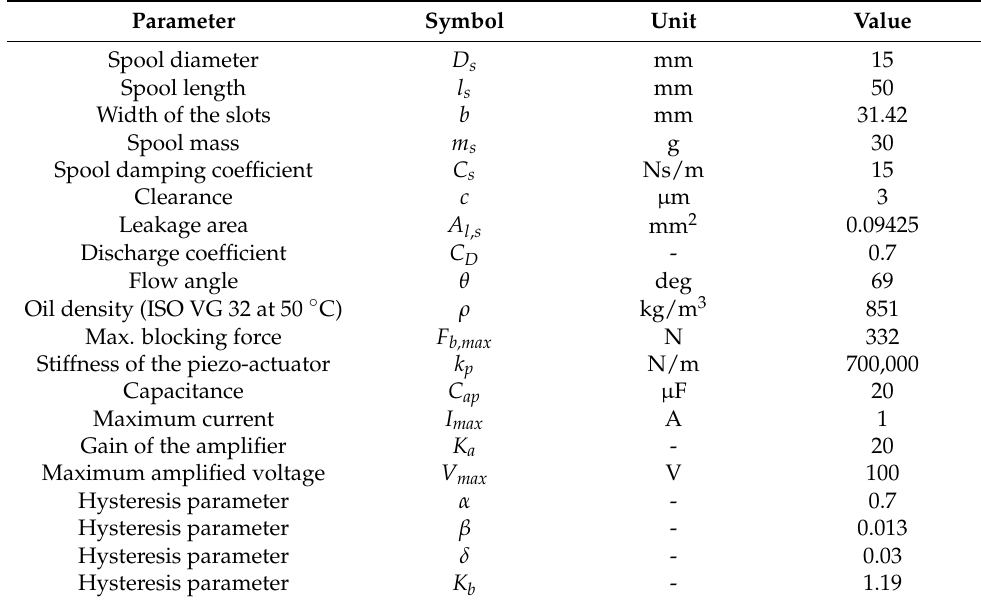
Table 2. Parameters employed in the simulations.